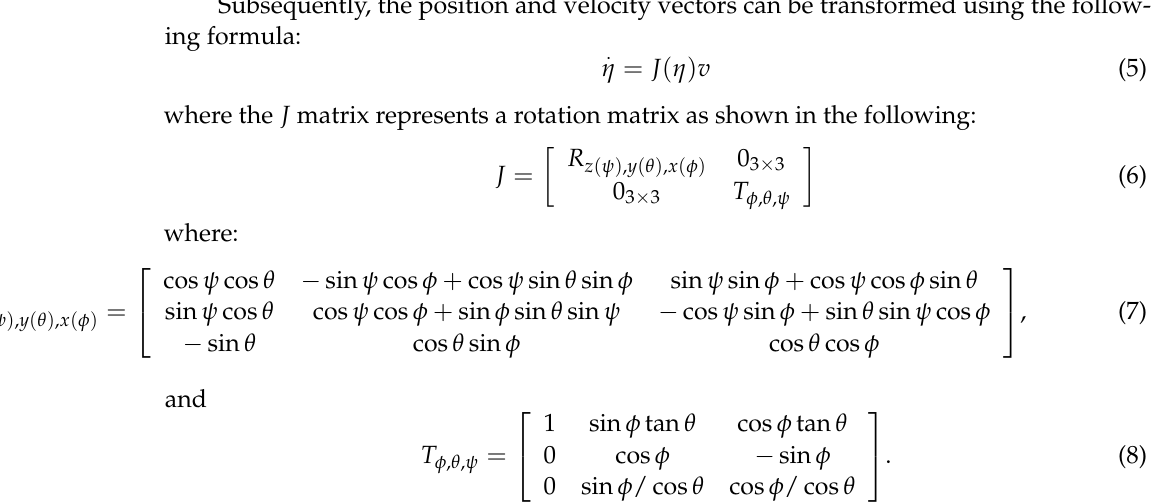
Figure 1. The ship system with six degrees of freedom.